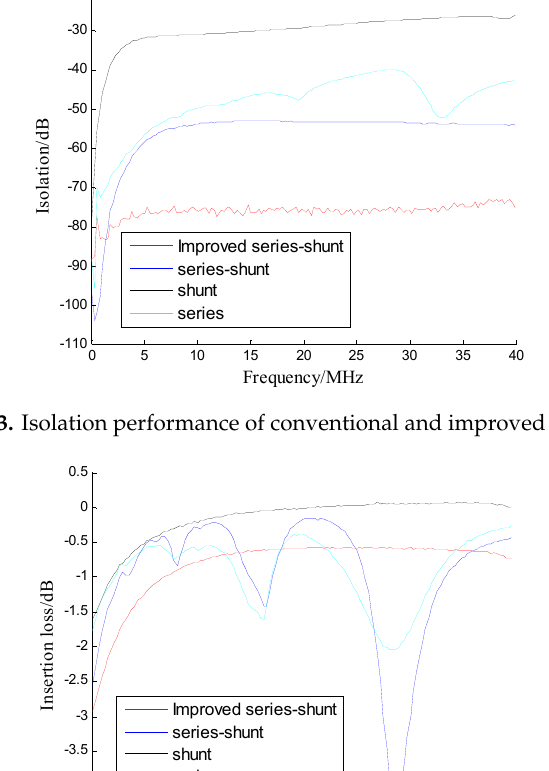
Figure 12. Experimental platform for testing the other technical metrics of RF switches: ( a ) Block diagram of the experimental platform and ( b ) Photograph of the experimental platform.